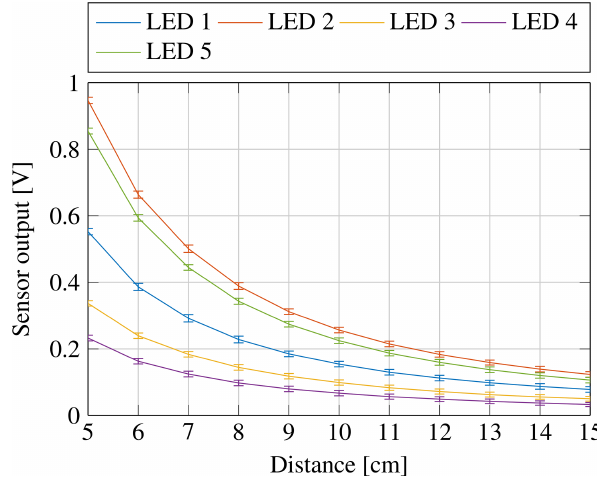
Figure 6. Sensor output at different distances from 5 to 15cm in 1cm step with the white tile surface without